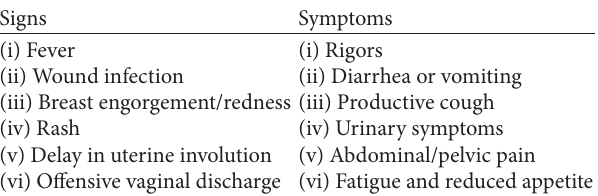
Table 1: Common signs and symptoms in puerperal sepsis. Signs